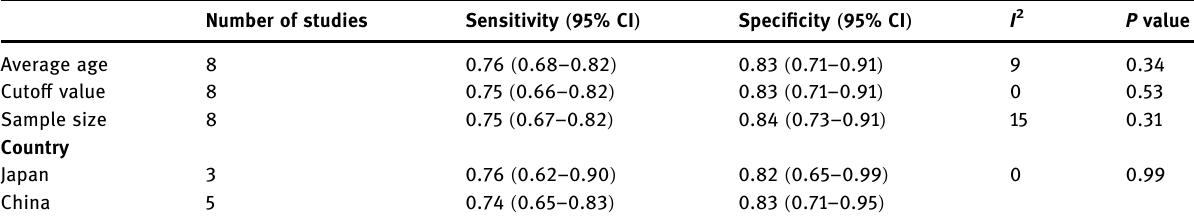
Table 3: Meta - regression results Number of studies